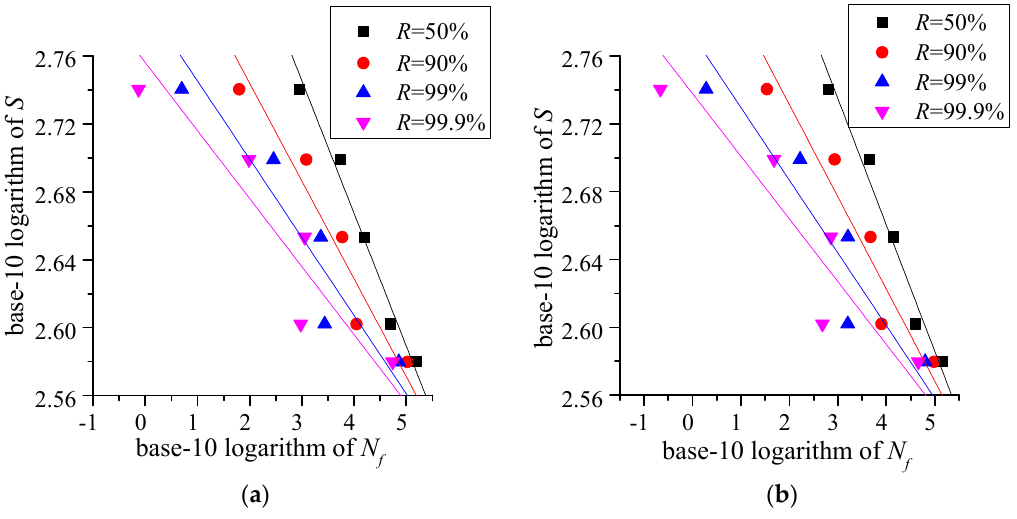
Figure 6. The P-S-N curves with R a = 0.4 µ m and confidence level ( a ) γ = 95%; and ( b ) γ = 99% .